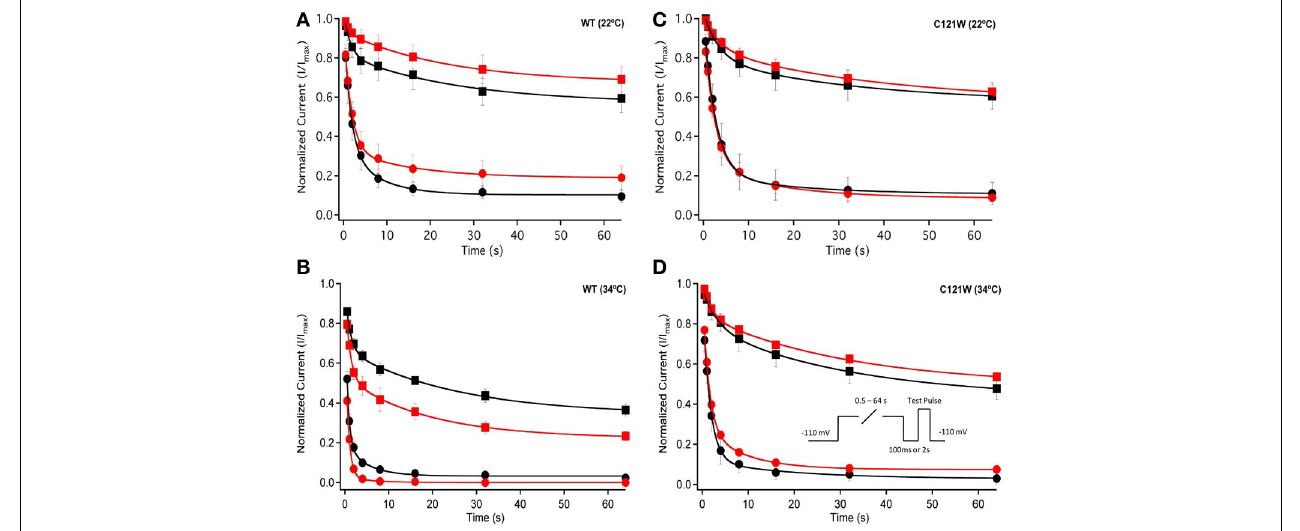
(black) and 100 μ M lacosamide (red). For both WT at 22 ◦ C and 34 ◦ C (A,B) and C121W at 22 ◦ C and 34 ◦ C (C,D) . Inset in (D) shows the pulse